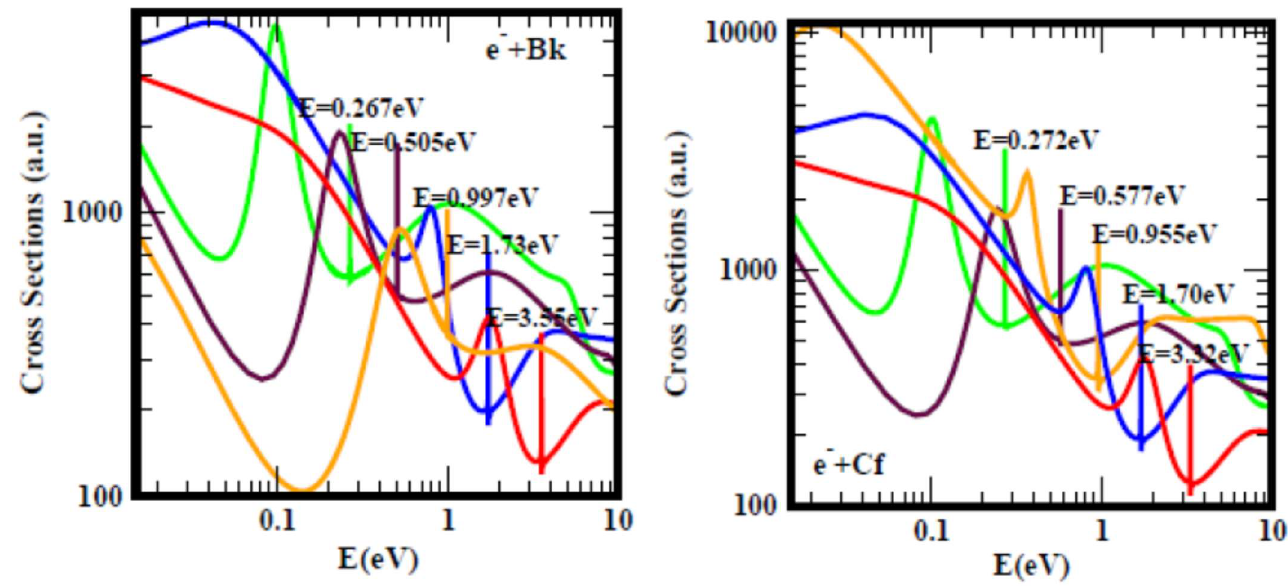
Figure 1. Total cross sections (a.u.) for electron elastic scattering from atomic Bk (left panel) and Cf (right panel) are contrasted. For both Bk and Cf the red, blue, and orange curves represent TCSs for the ground and the two metastable states, respectively, while the brown and the green curves cor- respond to excited state TCSs. The dramatically sharp resonances in the TCSs of both figures corre- spond to the Bk ˉ and Cf ˉ negative ions formed during the collisions. Importantly, the flip over of the near-threshold R-T minimum from the Bk TCSs to an SR very close to threshold in the Cf TCSs occurs